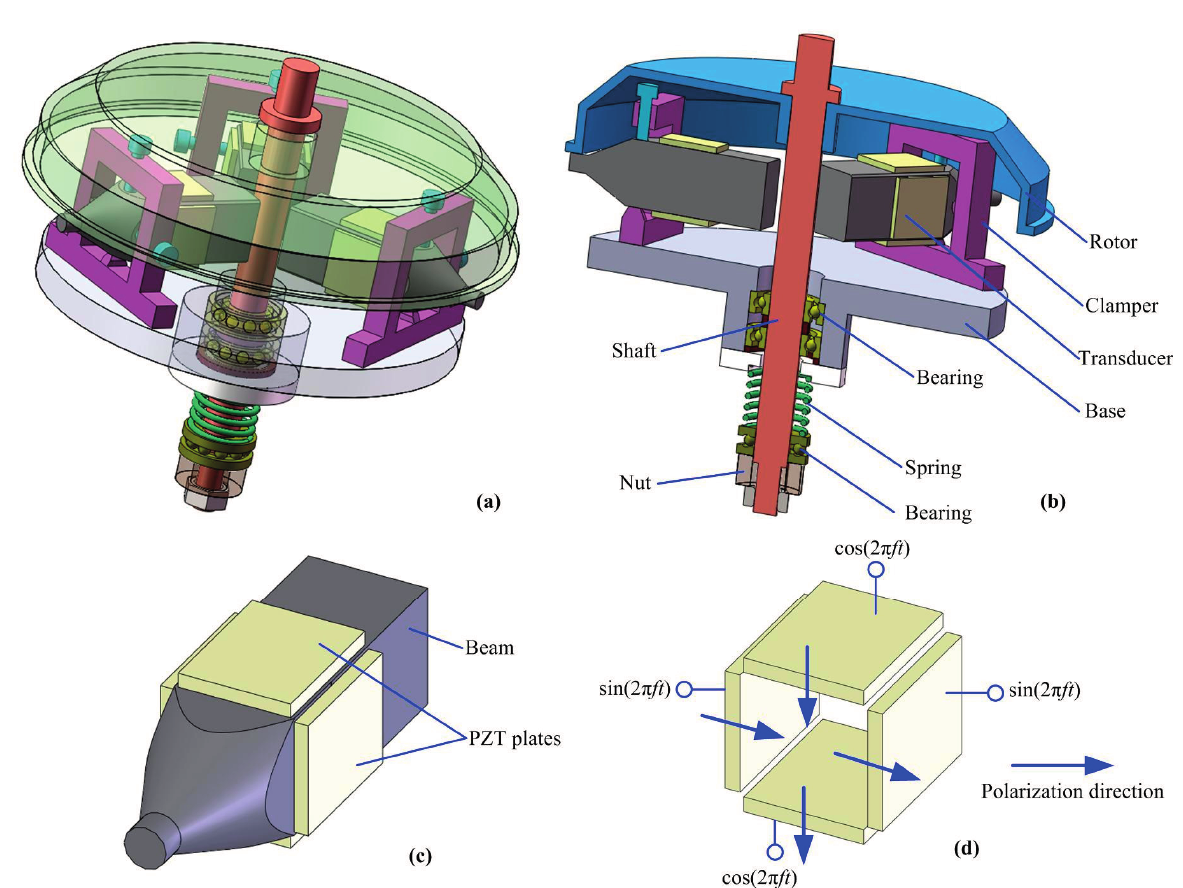
Figure 1. Structure of the proposed piezoelectric motor: ( a ) three-dimensional model; ( b ) section view; ( c ) the bending transducer; ( d ) polarizations of the PZT plates.